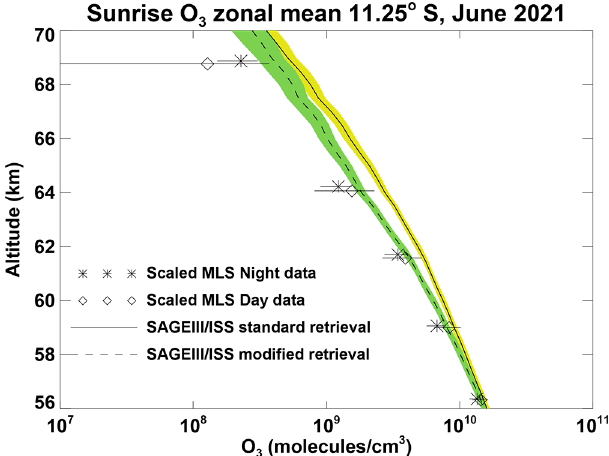
Figure 12. Comparison of sunrise SAGE III/ISS and MLS meso- spheric O 3 zonal mean at 11.25 ◦ S in June 2021. Solid line – mean of SAGE III/ISS standard retrieval with the standard devia- tion shown by the yellow shade; dashed line – mean of SAGE II- I/ISS modified retrieval with the standard deviation shown by the green shade; asterisks – mean MLS night data scaled to sunrise; di- amonds – mean MLS day data scaled to sunrise; horizontal lines represent the standard